Question: Write the caption for this figure.
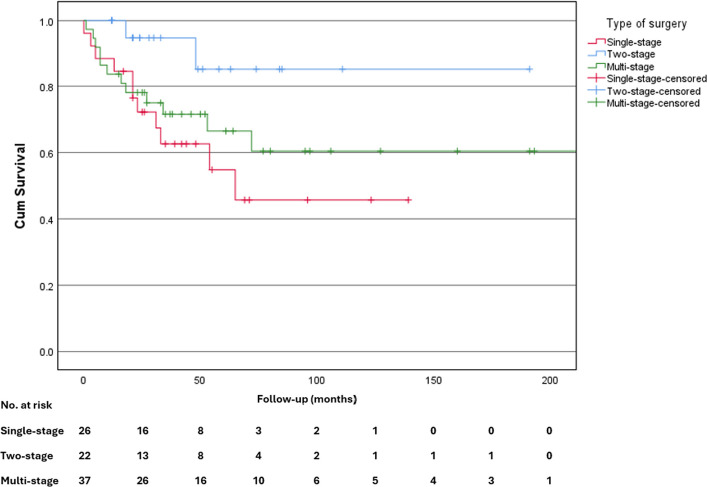
Answer: Kaplan–Meier analysis on overall implant survival. (= partial/total replacement of arthrodesis or above the knee amputation) comparing the type of surgery. Two-stage revision provided significantly better outcomes in comparison to single-stage revision (HR: 0.2 (95% CI 0.05–0.98); p = 0.048). There was no significant difference between single- and multi-stage revision (HR: 0.7 (95% CI 0.3–1.6); p = 0.395) and two- and multi-stage revision (HR: 3.6 (95% CI 0.8–15.9); p = 0.097)